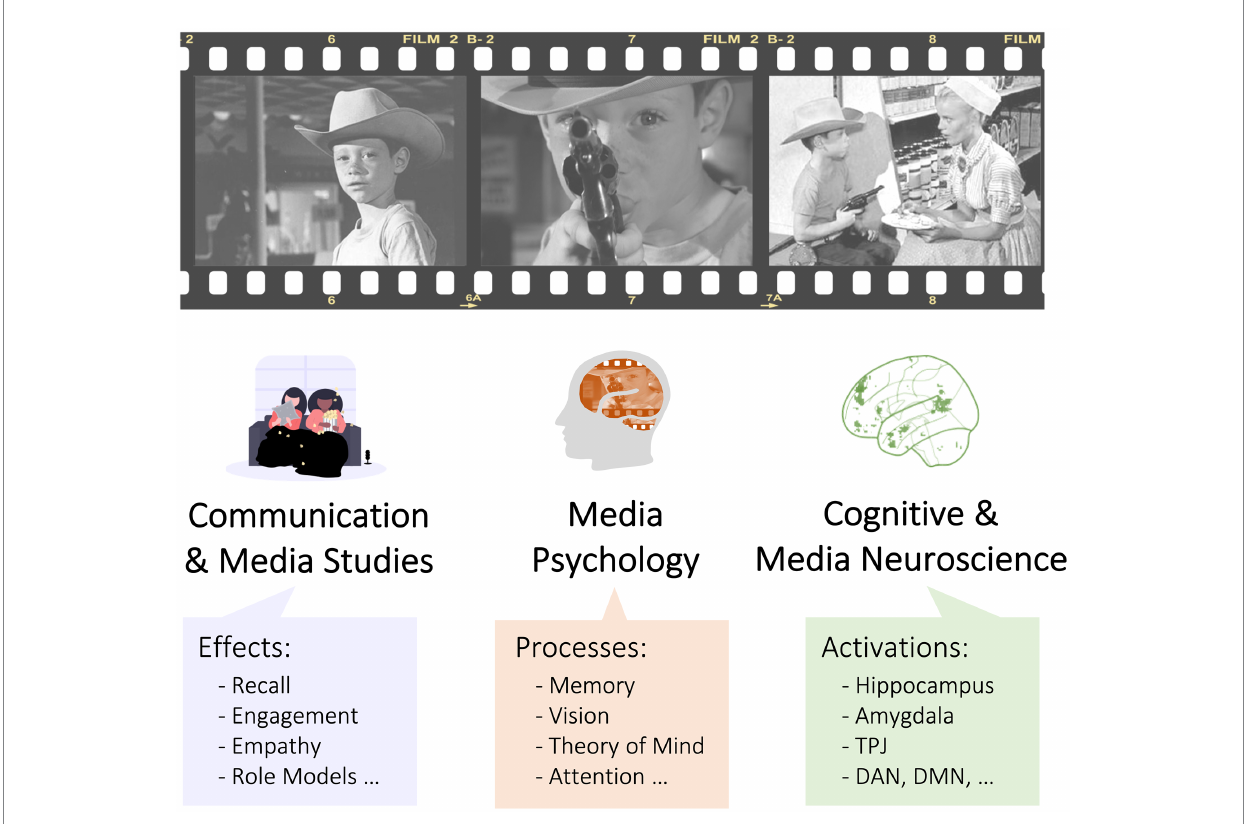
FIGURE 1 Connecting siloed fields of media effects, media processes, and media neuroscience. Traditionally, these topics have been studied by different academic